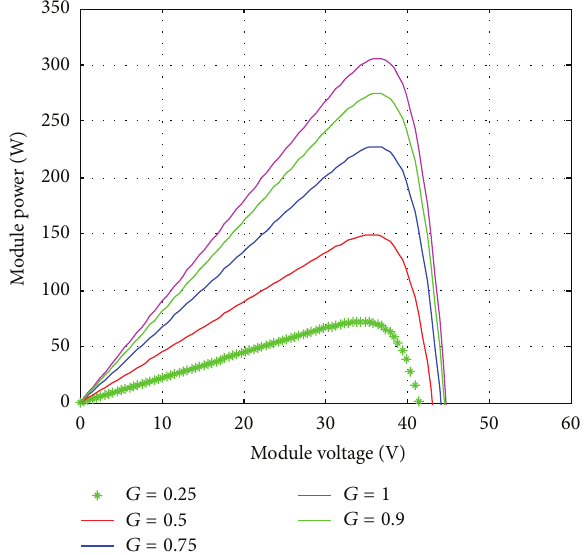
Figure 4: P - V characteristic of the PV module under different